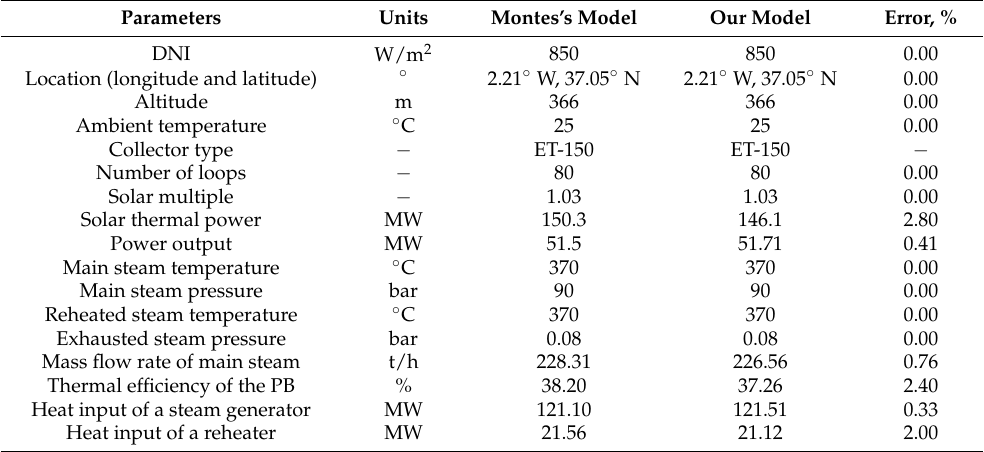
Table 3. Comparison of the main parameters and numerical results of 50 MW CSP plant.